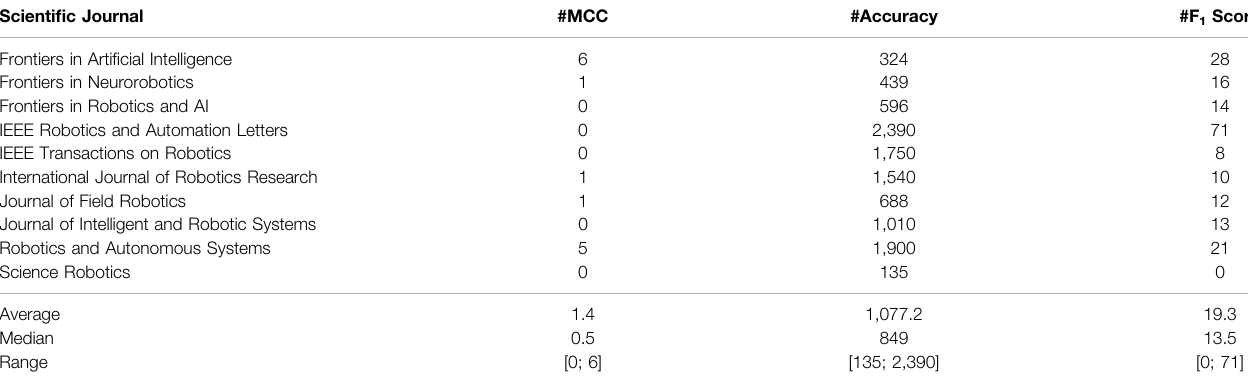
TABLE 1 | Occurrences of the keywords in the articles of the journals. #MCC: number of articles containing the “ Matthews correlation coef fi cient ” keyword for each journal. #accuracy: number of articles containing the “ accuracy ” keyword for each journal. #F 1 score: number of articles containing the “ F1 score ” keyword for each journal. We did all the searches on 14 February 2022 at 2:00p.m. EST, by using the source keyword on the Google Scholar search fi eld at https://scholar.google.com We sorted the scienti fi c journals